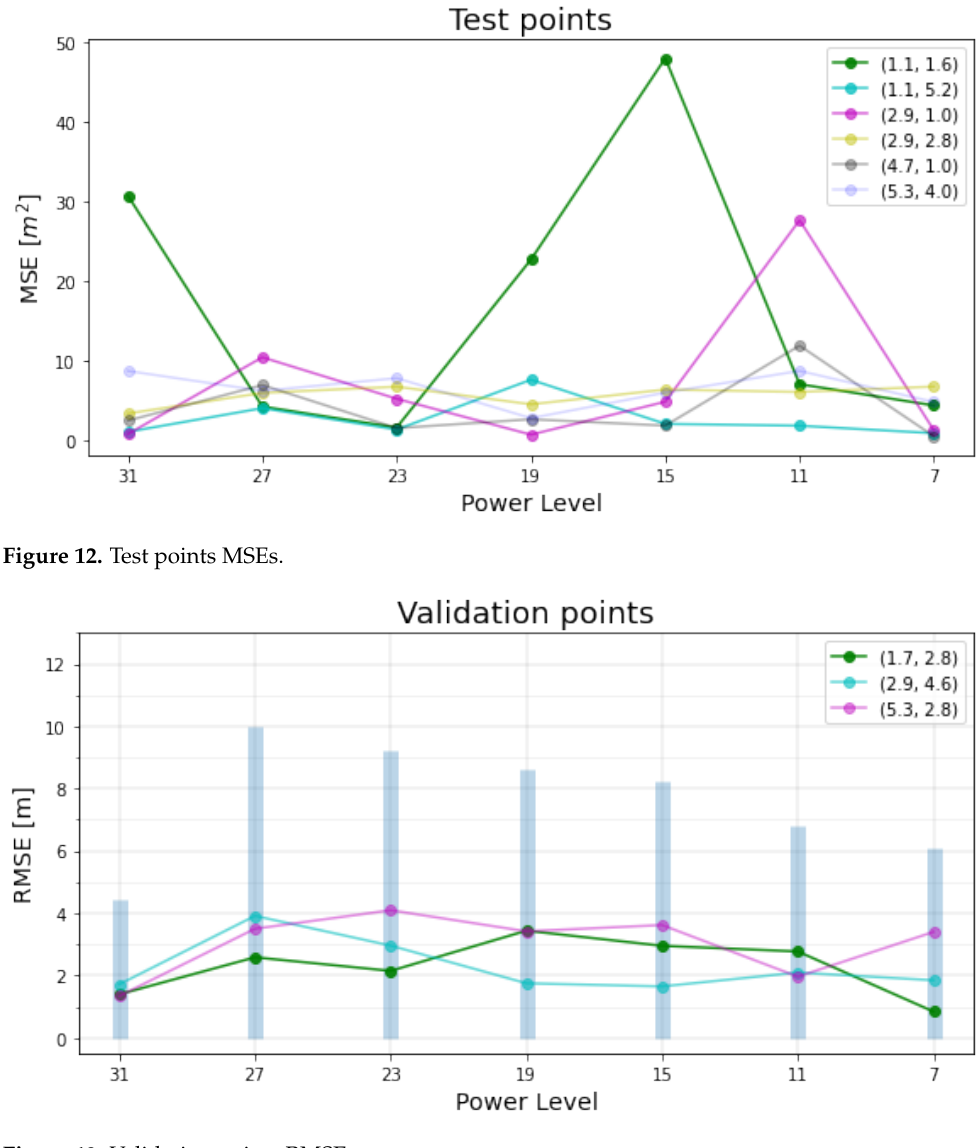
Figure 13. Validation points RMSEs. Vertical blue bins in Figure 13 indicates the RMSE summation for each validation point. Numerical values of the RMSEs are listed in Table 4. Table 4. Validation points total